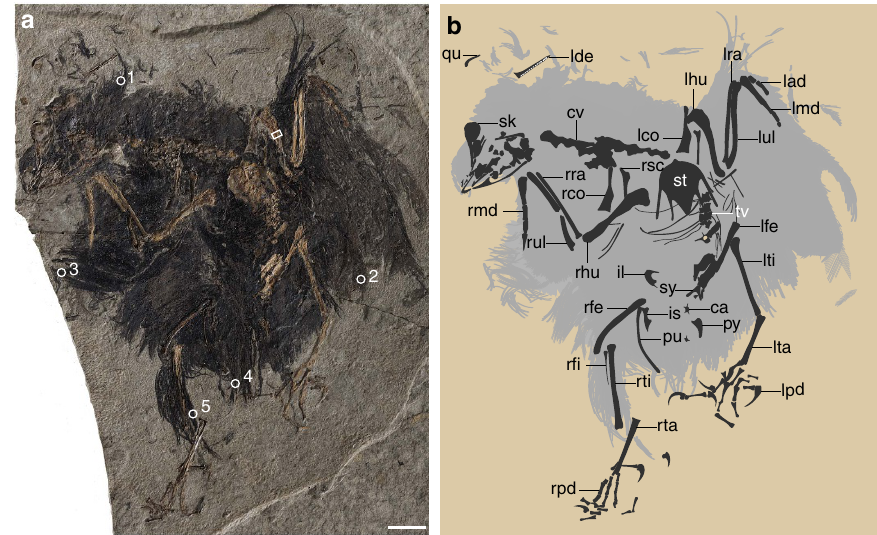
Figure 1 | Cruralispennia multidonta holotype (IVPP V21711). ( a ) Photograph; ( b ) line drawing. ca, caudal vertebra; cv, cervical vertebra; il, ilium; is, ischium; lad, left alular digit; lco, left coracoid; lde, left dentary; lfe, left femur; lhu, left humerus; lmd, left major digit; lpd; left pedal digits; lra, left radius; lta, left tarsometatarsus; lti, left tibiotarsus; lul, left ulna; pu, pubis; py, pygostyle; qu, quadrate; rco, right coracoid; rfe, right femur; rhu, right humerus; rmd, right major digit; rpd, right pedal digits; rra, right radius; rsc, right scapula; rta, right tarsometatarsus; rti, right tibiotarsus; rul, right ulna; sk, skull; st, sternum; sy, synsacrum; tv, thoracic vertebra. The white circles (numbered 1–5) and box indicate the locations of the feather and histological samples, respectively. Scale bar,